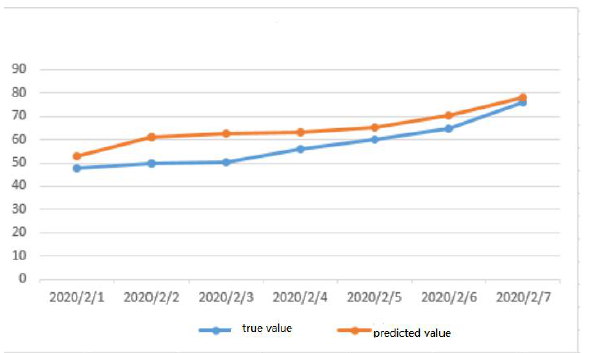
Figure 5. Beijing Dongsi Railway Station January 7 forecast value compared with the real value.